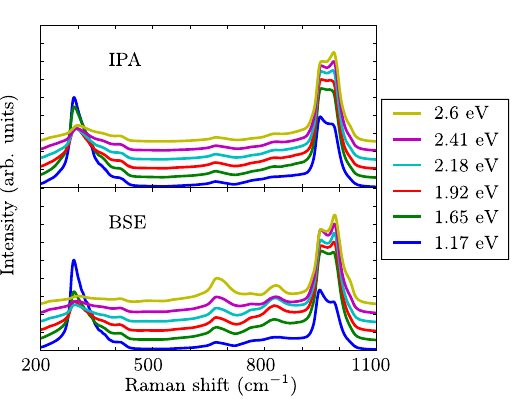
Figure 3. Second-order Raman spectra calculated within the IPA (top) and the BSE (bottom) for several excitation energies  ω . Each spectrum is normalized with respect to its highest value, as in Fig. L